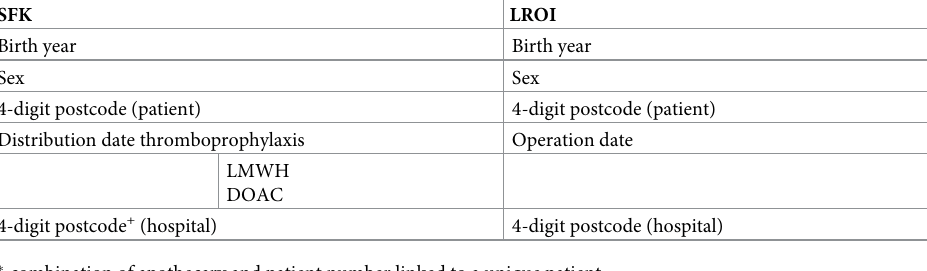
Table 2. Information from both registries and their counterpart in the other